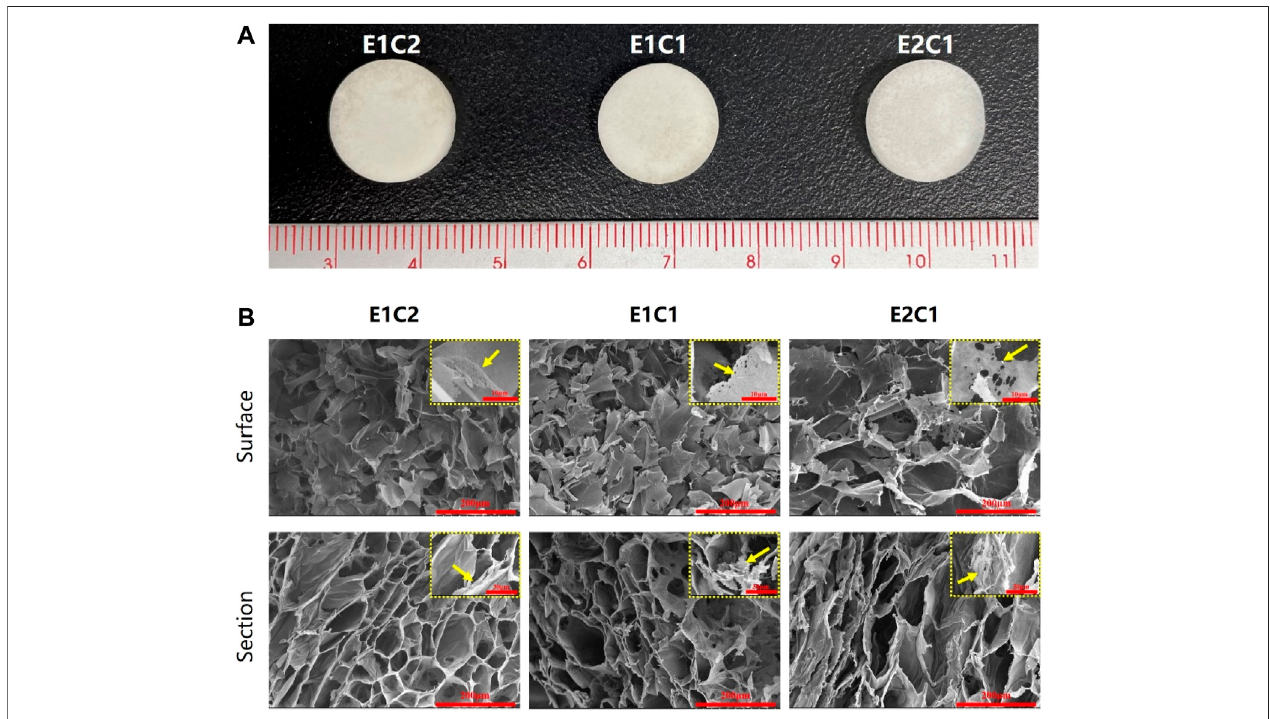
FIGURE 4 | FTIR analysis of the scaffolds. (A) Detection curve from 500 cm − 1 to 4,000 cm − 1 . (B) Enlarged view of the green area in the FTIR curve.